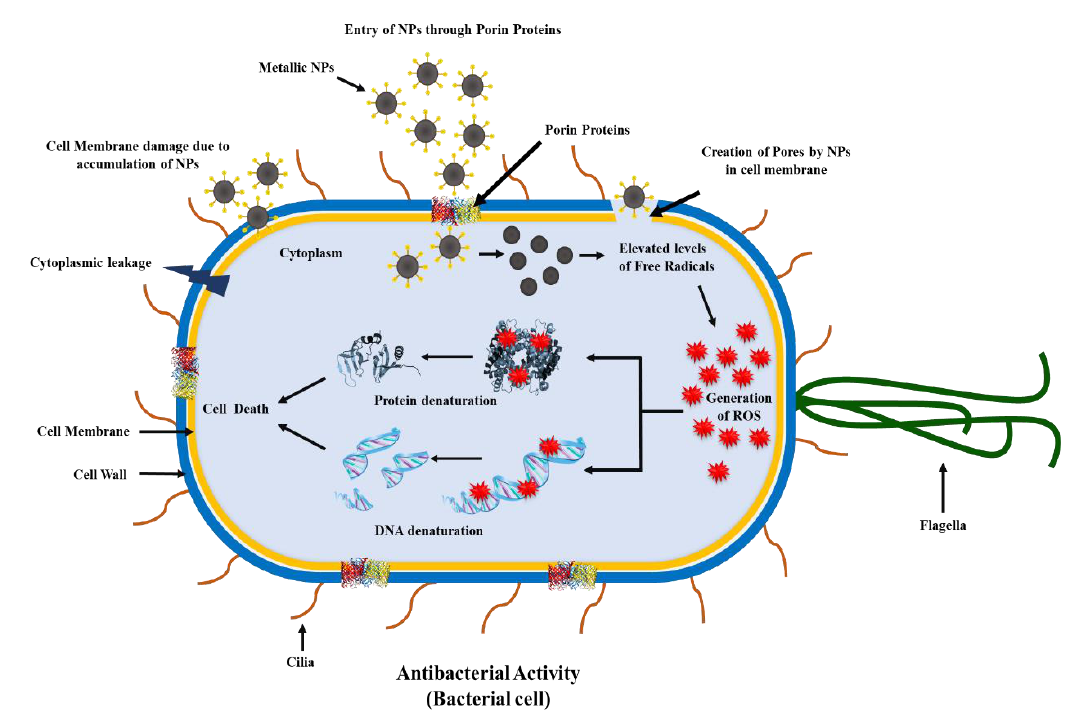
Figure 3. Antibacterial mechanism of fruit-polyphenol-functionalized nanoparticle with their target sites [119].